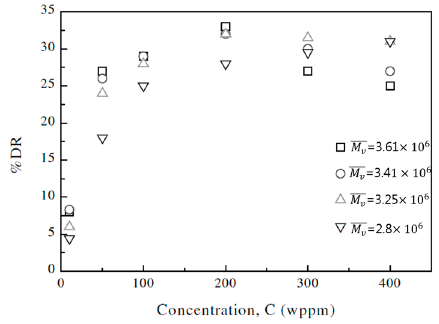
Figure 2. Initial % DR versus the xanthan gum concentration at four different molecular weights at 1800 rpm, reprinted with permission from [61]. Copyright Elsevier Science Ltd., 2001.